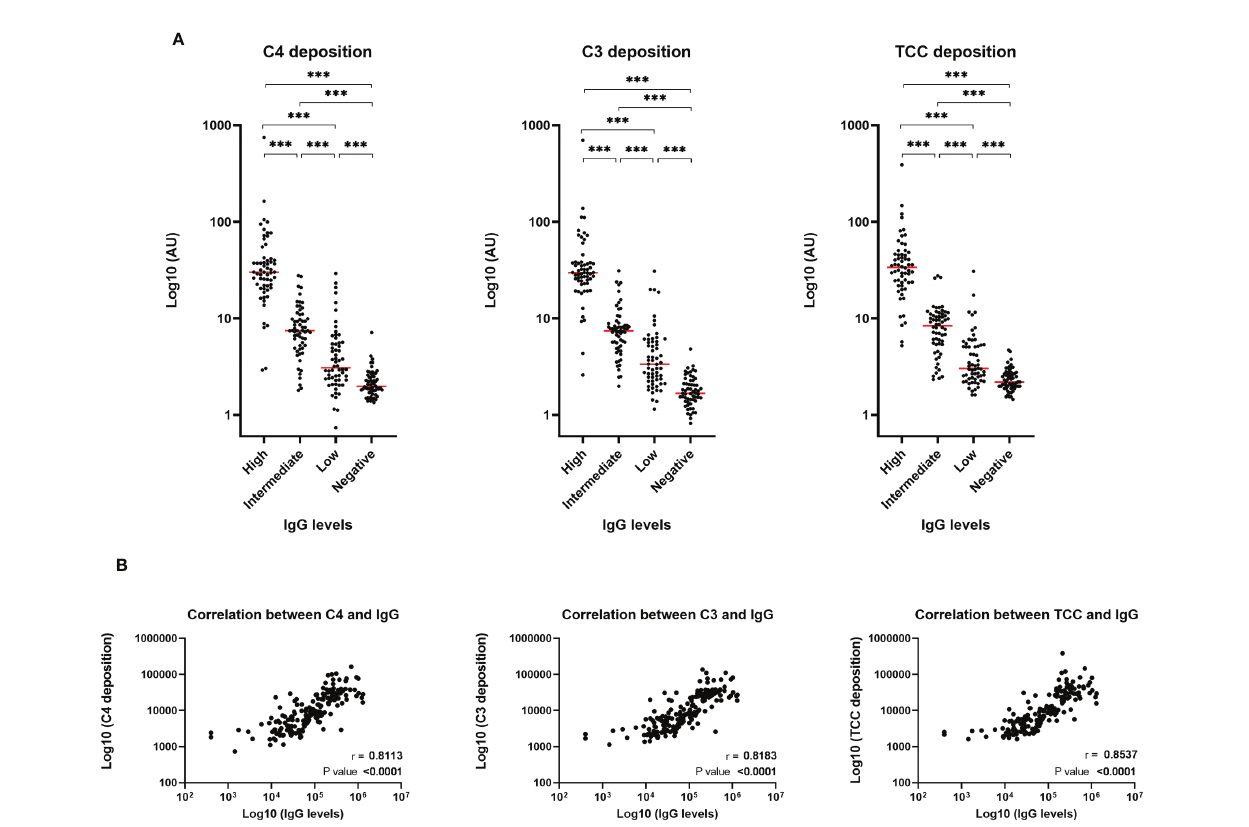
FIGURE 2 | Complement deposition in recovered SARS-CoV-2 individuals. (A) Measurements of complement components C4, C3 and TCC in convalescent EDTA plasma. Groups divided according to levels of total IgG; high, intermediate, low and negative healthy controls, n = 240. Levels were assessed by coating plates with 3 µg/nm RBD, followed by incubation with EDTA plasma diluted 1:60 (for high IgG samples) and 1:20 (for intermediate, low and negative IgG samples). A normal human serum pool was applied in a 1:50 dilution. Biotinylated monoclonal antibodies against C4b, C3bc and TCC (2 µg/ml) was used for detection. Dynamic range represented in arbitrary units (AU). A p value < 0.05 was considered signi fi cant. ***p < 0.001 using Tukey all-pair comparisons. (B) The correlation between deposition of either C4, C3 or TCC and IgG levels using Spearman rank correlation